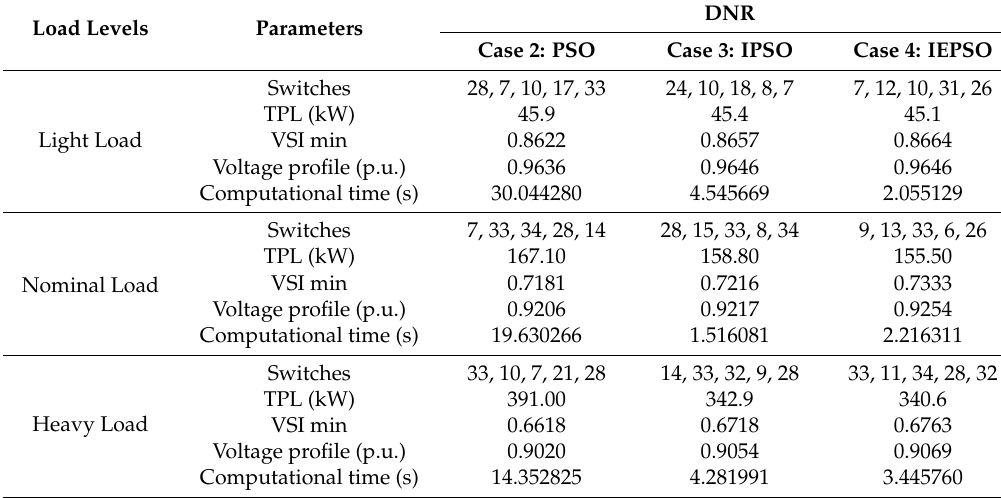
Table 3. The performance of particle swarm optimization (PSO), improved particle swarm optimization (IPSO) and IEPSO for DNR implementation in 33-bus radial distribution